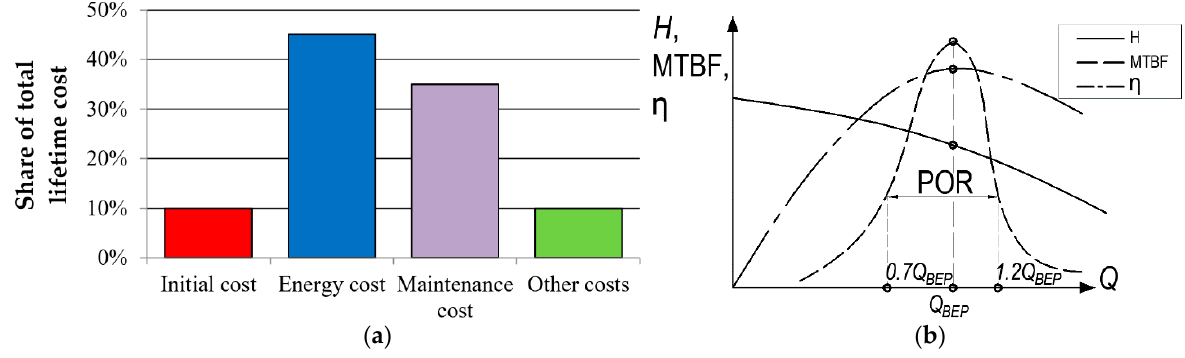
Figure 1. ( a ) Life cycle costs for a pump unit [1]; ( b ) Head H, MTBF, and efficiency η of a pump versus flow Q [2].